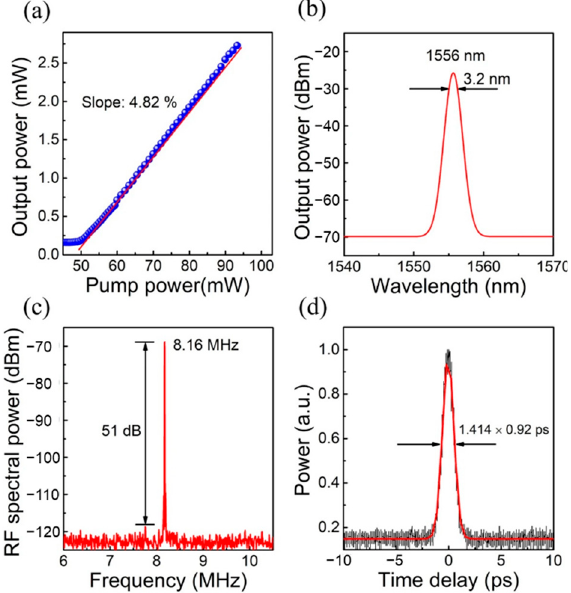
Figure 24. Characteristics of the mode-locked developed fiber laser. ( a ) Output power versus pump power. ( b ) Output optical spectra. ( c ) RF spectrum of the mode-locked fiber laser. ( d ) Autocorrelation trace. Reproduced with permission from [192]. Springer Nature, 2019.